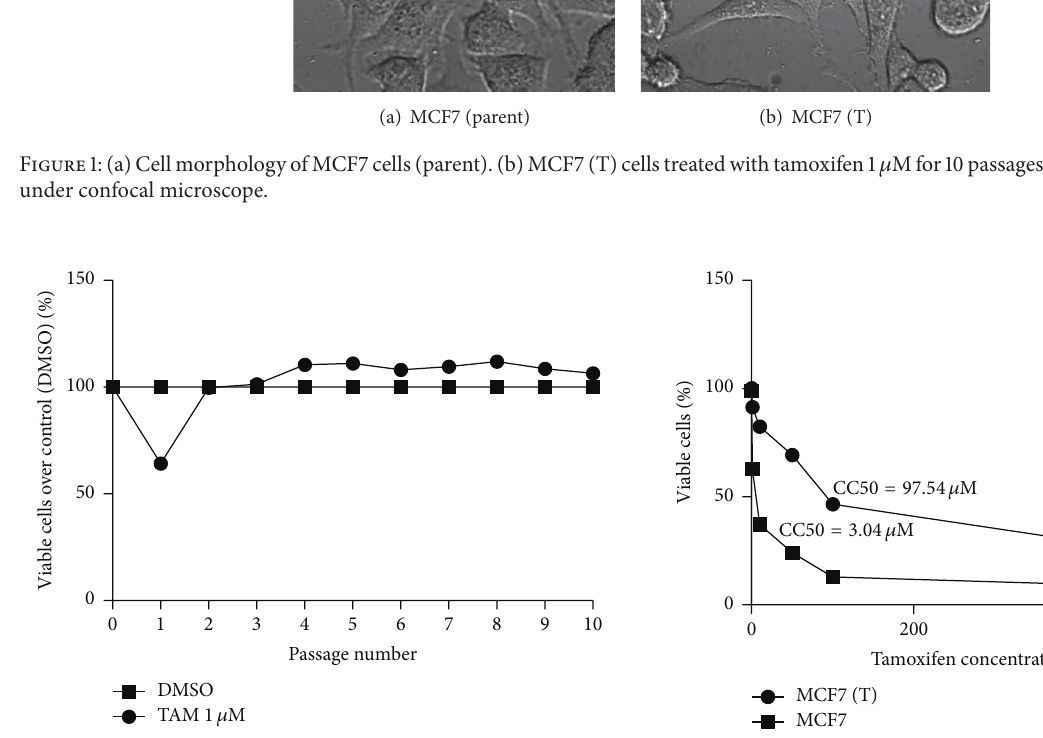
Figure 3: Cytotoxicity concentrations 50 (CC50) of tamoxifen in MCF7 or MCF7 (T)